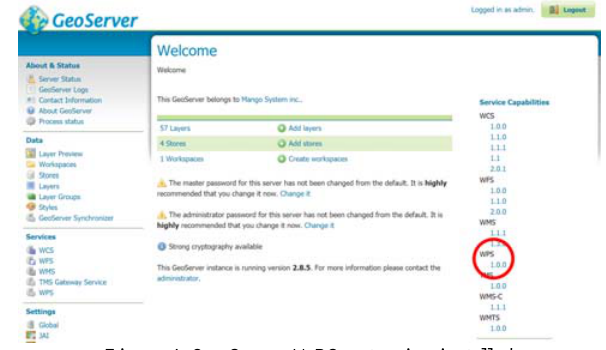
Figure 4. GeoServer WPS extension installed